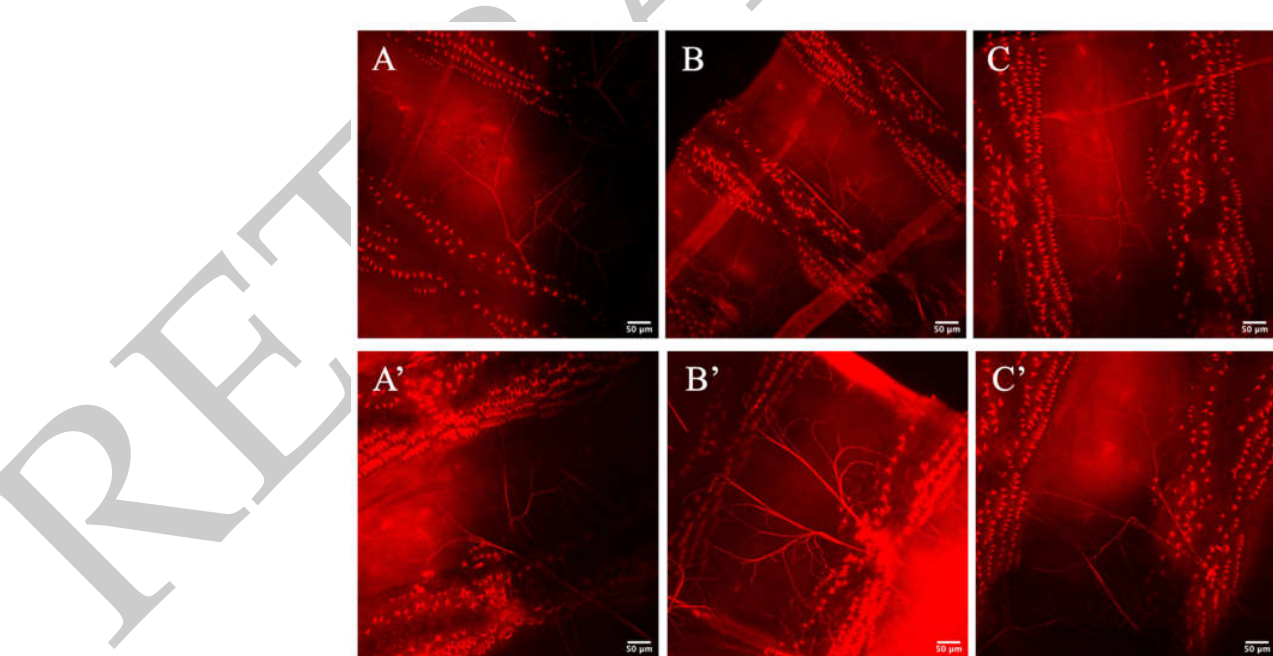
Figure 7. Lumenogenesis of controls and mutants. ( A ‒ C ) represent the lumens in the control cells. ( A’ ‒ C’ ) represent lu- mens of the RNAi knockdown cells. The triangular structures represent denticles in the terminal cells irrelevant to the discussion of lumen